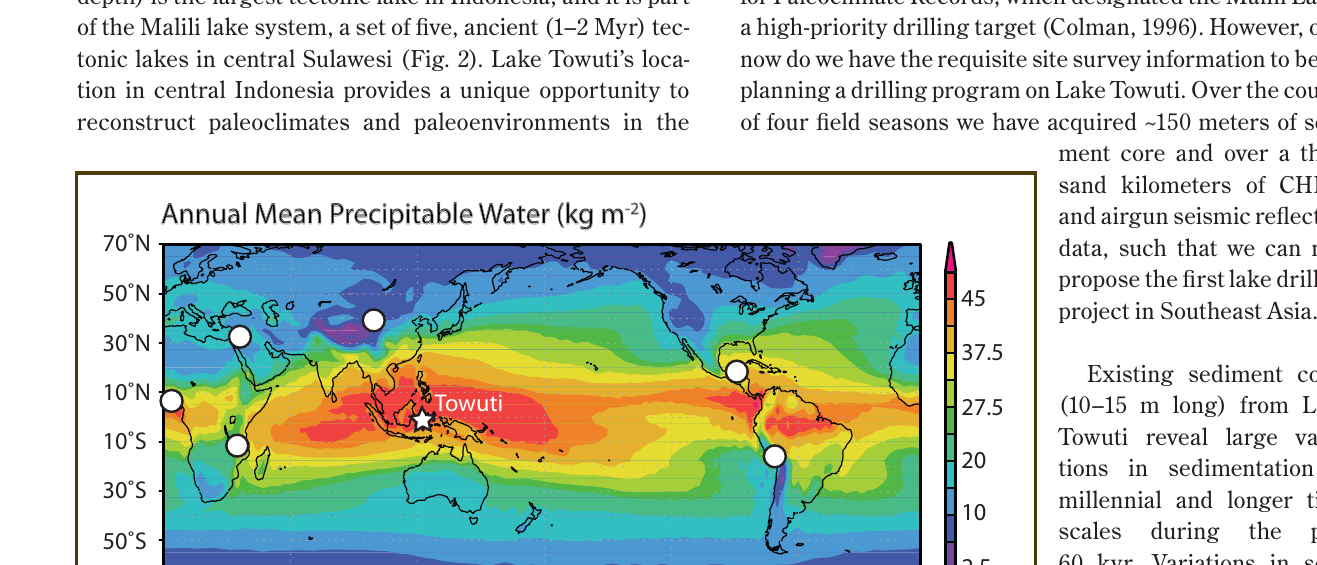
Figure 1. Annual mean precipitable water content of the atmosphere from NCEP Reanalysis (Kalnay et al., 1996), highlighting the importance of the Indo-Pacific to the global atmospheric water cycle. The star indicates the location of Lake Towuti. Circles indicate locations of previous ICDP lake drilling projects in the tropics and subtropics.